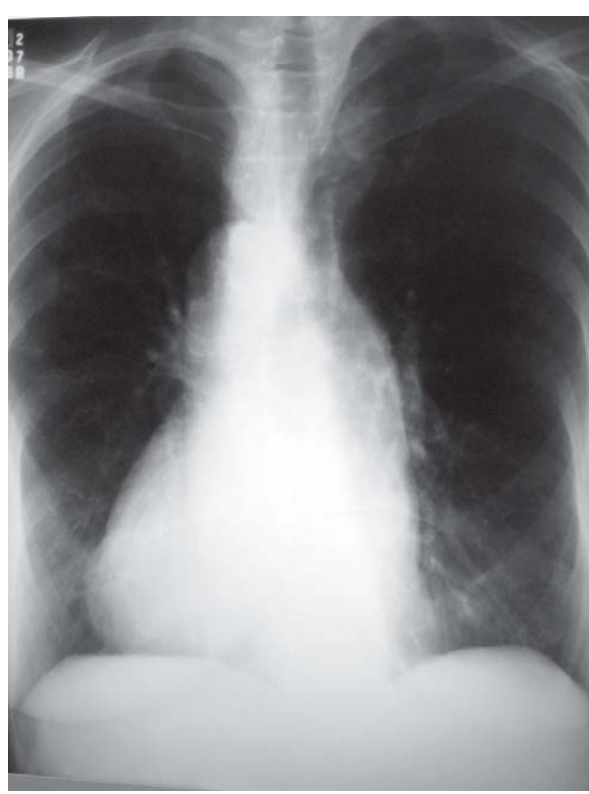
Fig. 1 – Radiografia de tórax em posição ântero-posterior, demonstrando dextrocardia